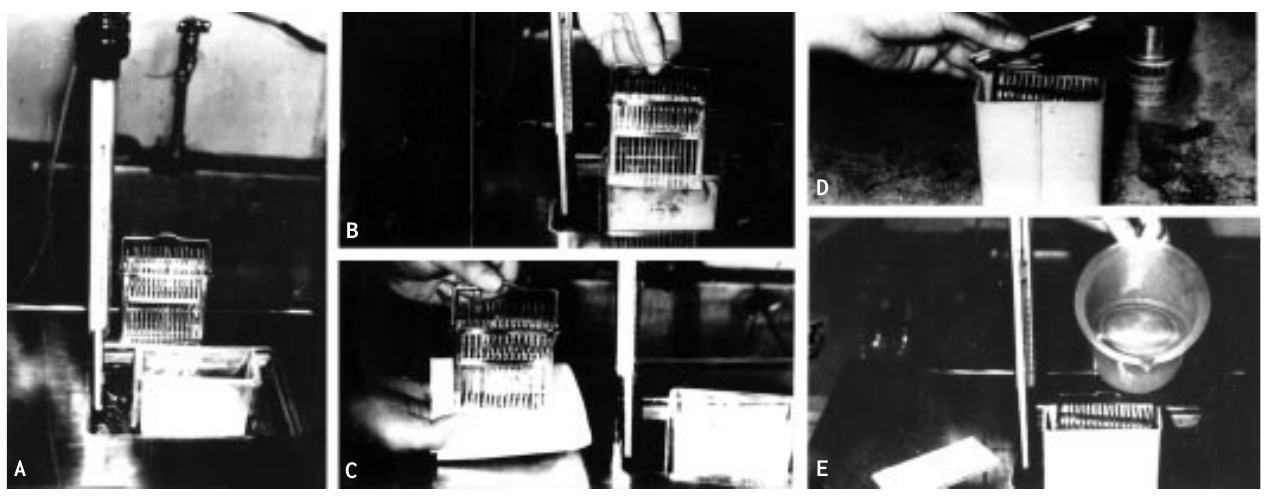
Figure 3 - Photographs showing the standard procedure for preparing LMRAG by the dipping method. A, Fifteen glass slides carrying sections are placed on a stainless steel slide holder, while bulk emulsion is melted and diluted with distilled water in a staining jar. B, The slide holder is dipped into the melted emulsion and pulled up vertically. C, Excess emulsion is wiped off with paper towels or tissue paper. D, The slide holder is stored in a light- tight slide box for exposure. E, After an appropriate exposure time, the developer is poured into the slide box and all the slides are developed